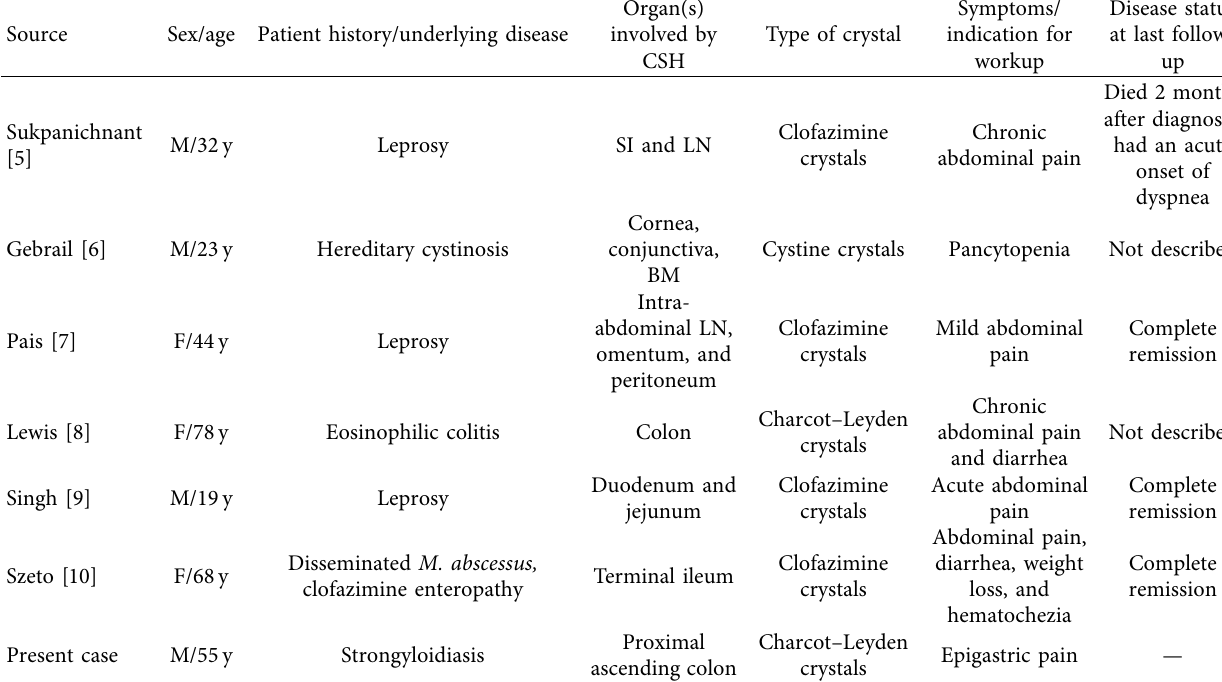
Table 1: Nonimmunoglobulin CSH reported in